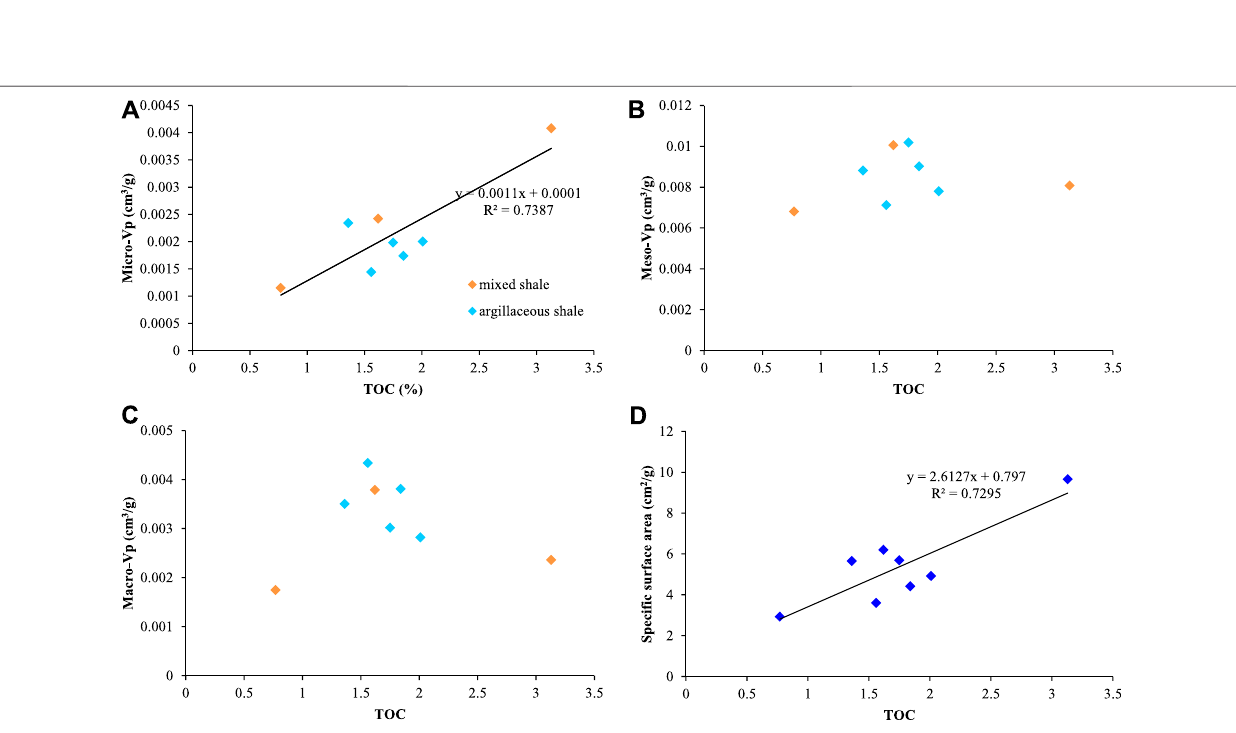
FIGURE 9 | Intersection diagrams of TOC and pore structure parameters. (A) TOC and micro-V p ; (B) TOC and meso-V p ; (C) TOC and macro-V p ; (D) TOC and speci fi c surface area.